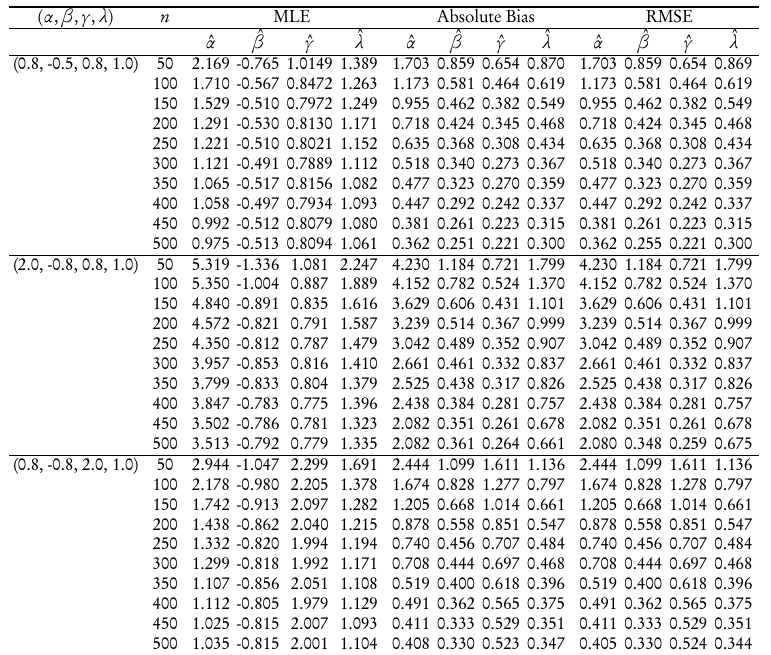
The MLEs, Std and RMSE for models